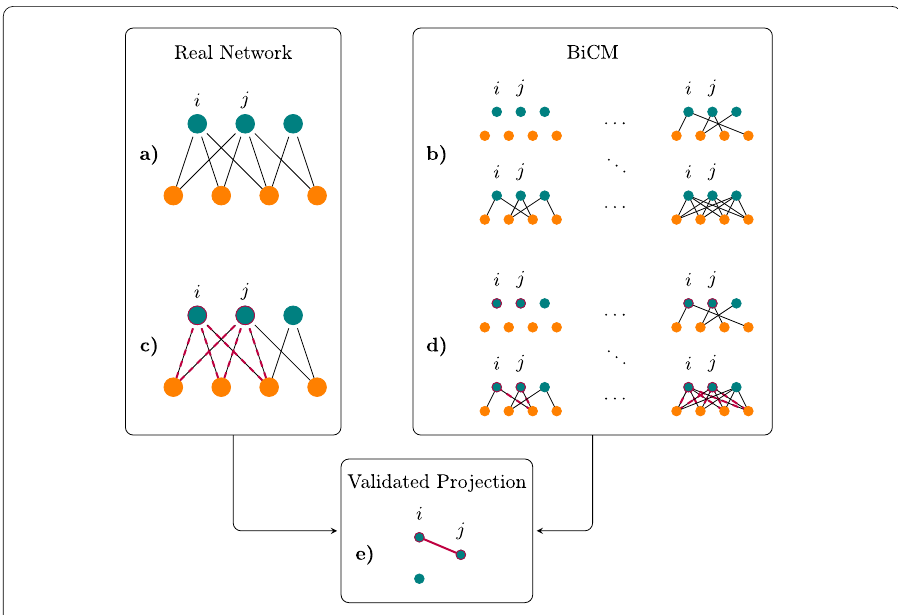
Figure 6 Schematic representation of the projection procedure for bipartite undirected networks. ( a ) An example of a real bipartite network. For the actual application, the two layers represent verified (turquoise) and unverified (gray) users and a link between nodes of different layers is present if one of the two users retweeted the other one, at least once. ( b ) Definition of the Bipartite Configuration Model (BiCM) ensemble. Such ensemble includes all possible link realisations, once the number of nodes per layers has been fixed. ( c ) we focus our attention on nodes i and j , i.e., two verified users, and count the number of